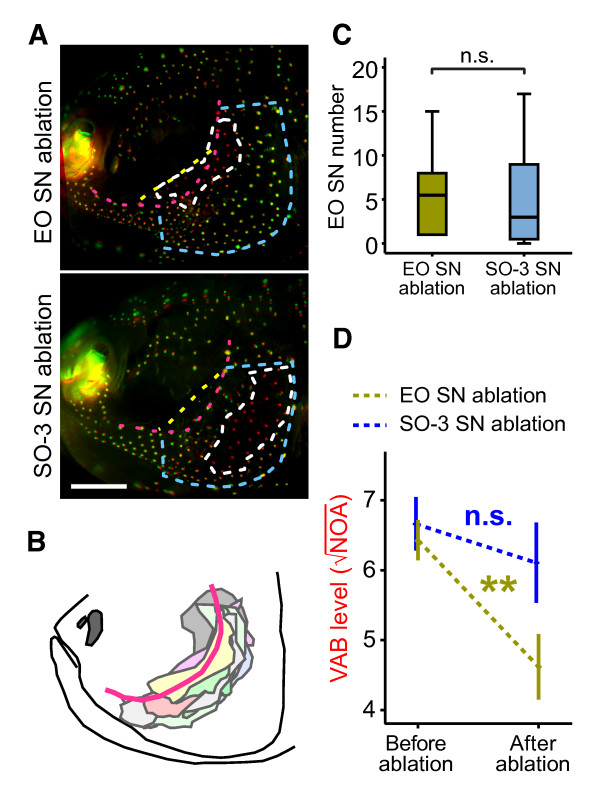
Effects of bilateral SN ablation on VAB in cavefish. (A) Comparison of DASPEI-stained EO SN and SO-3 SN in the ablated areas. The SN present before but absent after ablation within the two ablated regions (outlined by dashed white lines) are pseudo-colored in red. The red dashes indicate the line of suborbital canal neuromasts in the head lateral line and the areas enclosed by the blue dashed lines indicate the SO-3 region; the areas between the suborbital canal lateral line (red dashes) and dashed yellow lines represent the region containing EO SN. Scale bar in (lower panel of A) is 1.0 mm. (B) Schematic drawing of the ablated areas of 10 cavefish in the EO SN ablation experiment. Each experiment was color-coded. The snout is shown at the left. The ablated area included both the EO region and a part of the SO-3 region. The suborbital canal lateral line is indicated with red line. (C) The EO SN number of cavefish prior to ablation of EO or SO-3 SN. There was no difference in EO SN number between these two groups (Z = -0.54, P = 0.614; n = 10 for EO SN ablation; n = 7 for SO-3 SN ablation). (D) VAB in cavefish before SN ablation and four to six days after SN ablation. Values are means ± s.e.m. **: P < 0.01. n.s.: not significant. Number of cavefish used were: n = 10 for EO, n = 7 for SO-3. Rod vibration at 35 Hz was used to measure VAB.